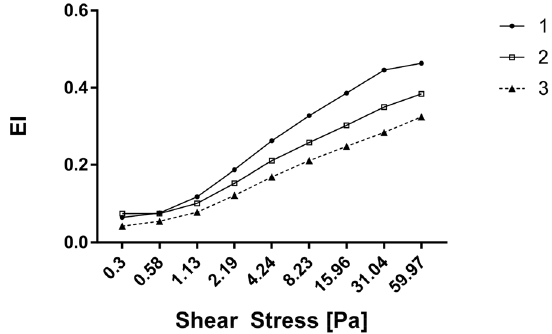
Figure 1. Red blood cells: elongation index (EI) depending on shear stress in the performed measurements (1, 2, 3).